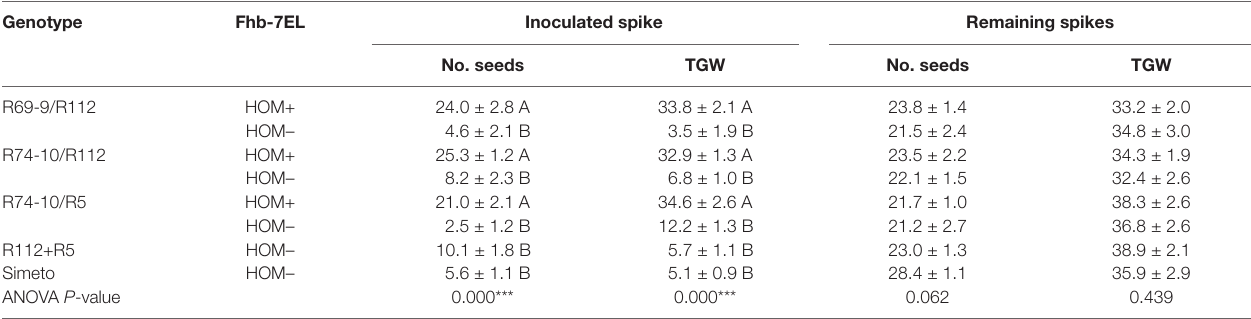
TABLE 5 | Effects of F. graminearum infection on fertility traits of mature spikes of durum wheat homozygous carriers (HOM+) and non-carriers (HOM−) of the Fhb-7EL QTL. Genotype Fhb-7EL Inoculated spike Remaining